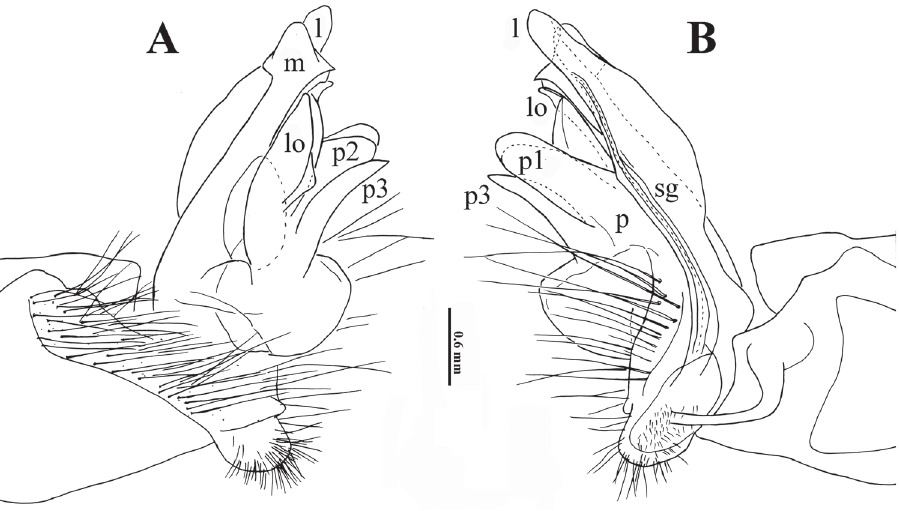
Figure 6. Trichopeltis intricatus sp. n., ♂ holotype. A–B right gonopod, lateral and mesal views, respec- tively. Abbreviations: l = apical lobe; lo = lobules; m = mushroom-shaped lobe; p = acropodital process; p1–3 = processes 1–3; sg = seminal